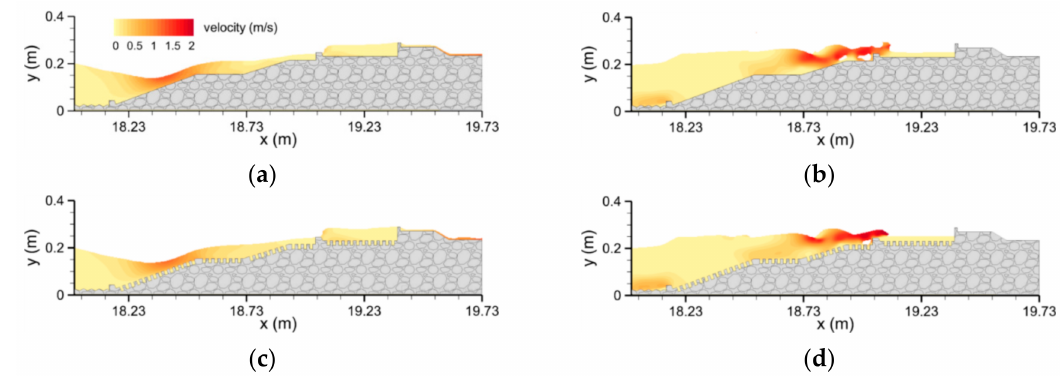
Figure 9. Velocity distribution during wave run-up and wave breaking with and without the fence plate; ( a , b ) without fence plate; ( c , d ) with fence plate.